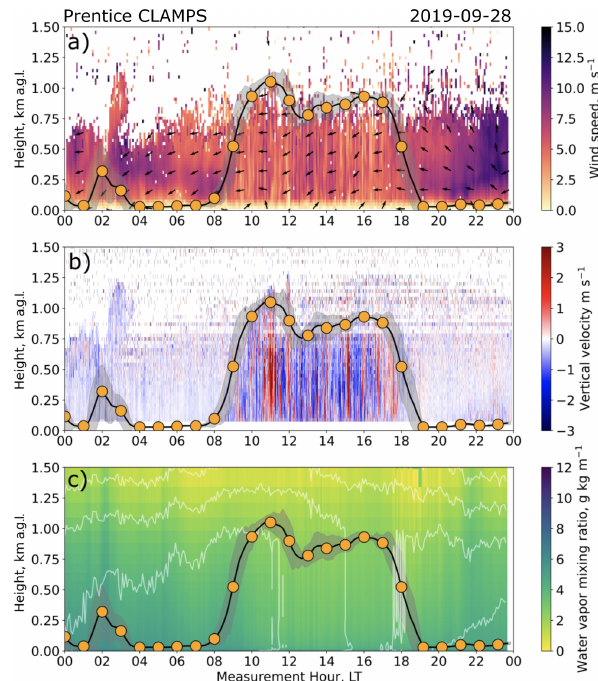
Figure 4. (a) Time–height cross section of horizontal wind speed and direction (fill and arrows, respectively), (b) vertical velocity (positive indicates upward motion) as detected by the Doppler li- dar and TROPoe retrieved water vapor mixing ratio (fill), and (c) potential temperature (contour; 285–300K every 2.5K) from AERI and MWR observations from the CLAMPS deployed at the Pren- tice site on 28 September 2019. Overlaid are hourly (orange dots) and 10min (black curve) PBLH estimates from the CLAMPS fuzzy logic algorithm. The grey fill behind the PBLH estimates is a quasi- measure of variability represented by the standard deviation of all 10min estimates within a sliding 1h wide window centered on each 10min